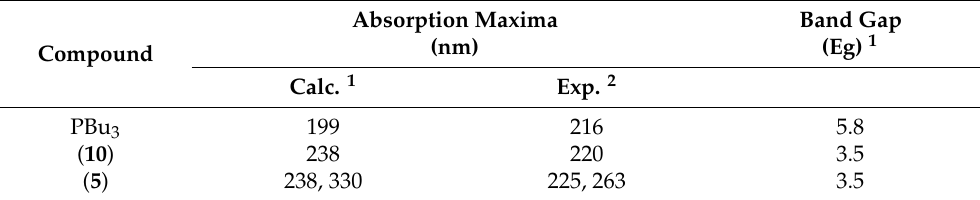
Table 1. Absorption data and band gaps of ( 5 ), ( 10 ), and tributylphosphine (PBu 3 ).